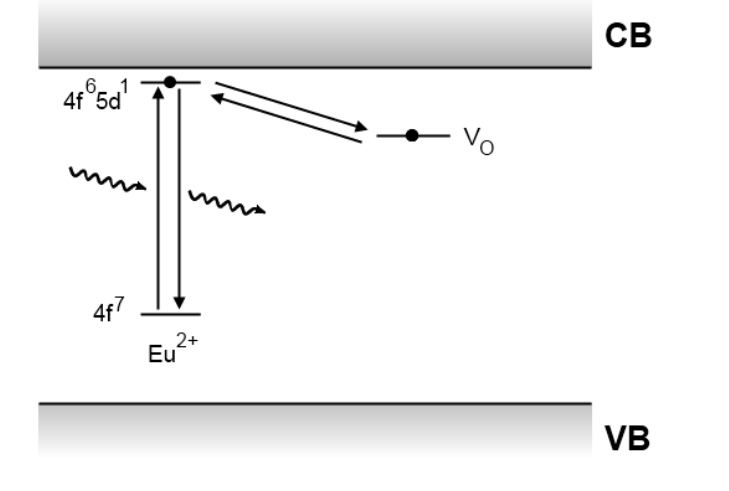
10. Persistent luminescence mechanism proposed by Clabau et al . for SrAl O :Eu 2+ ,Dy 3+ 2 4